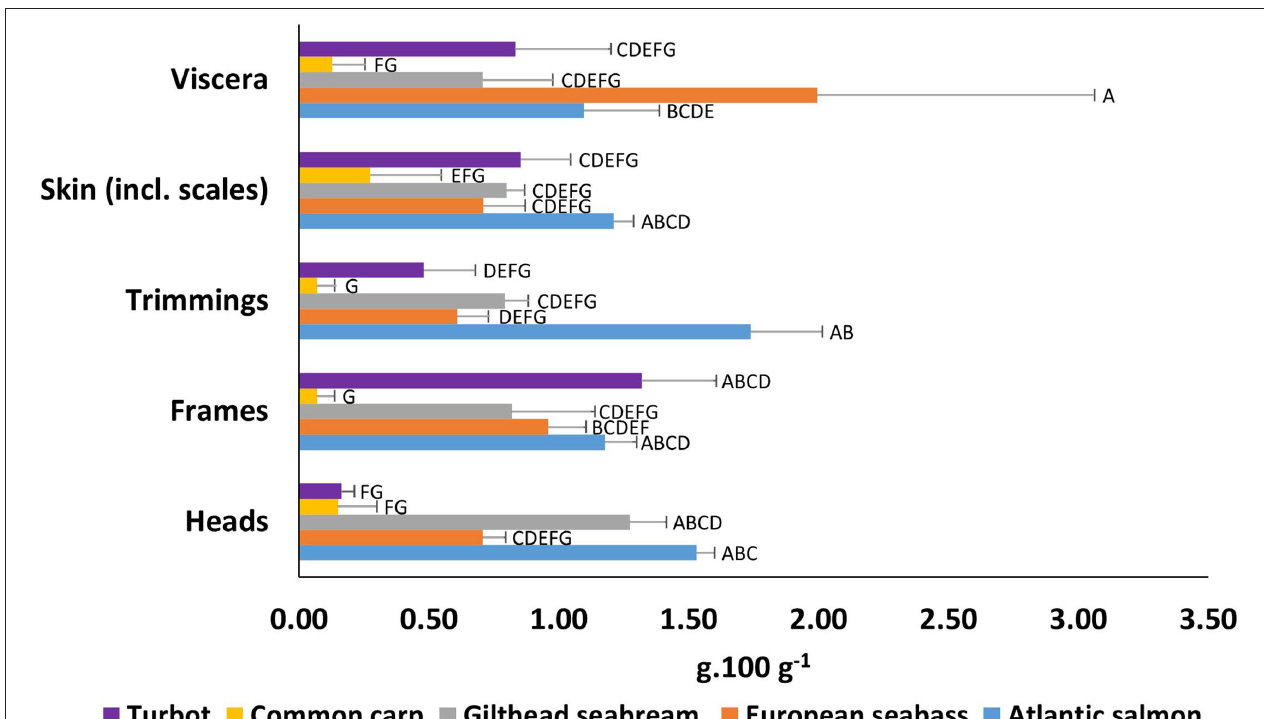
FIGURE 3 | Total EPA + DHA content (g.100 g − 1 ) of wet weight by-products from European aquaculture species. Means that do not share letter(s) (A–G) are significantly different.